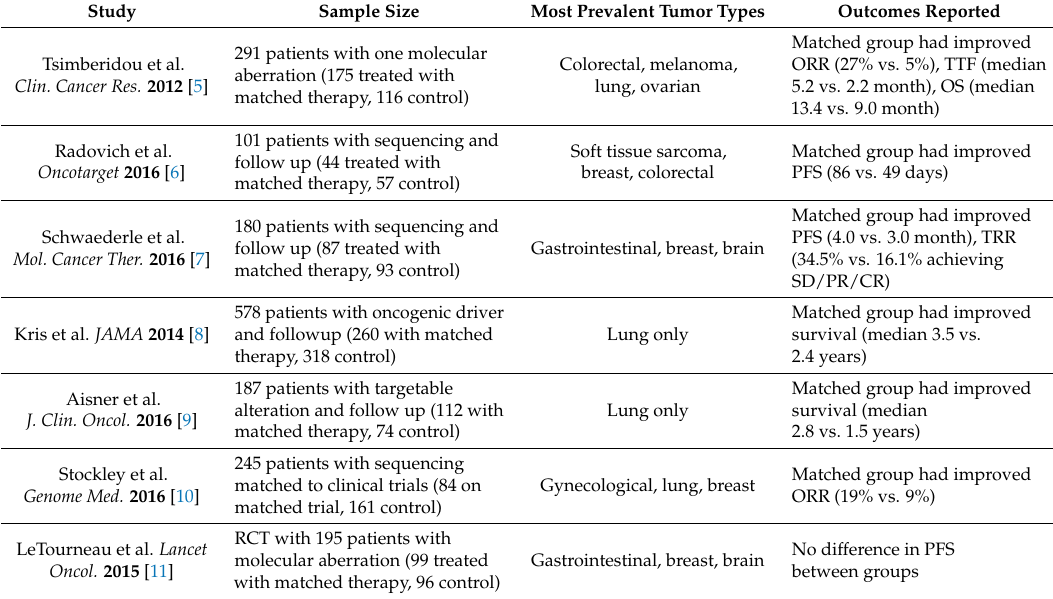
Table 1. Summary of Outcomes in Oncology Precision Medicine